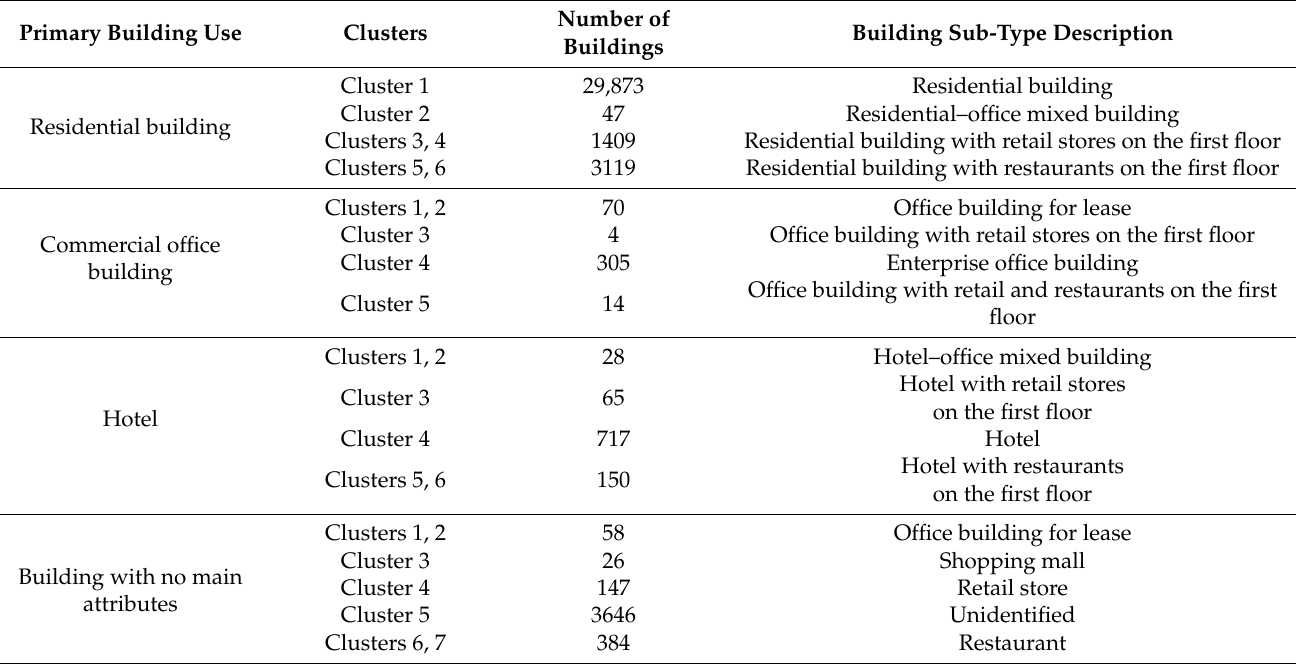
Table 6. Building sub-types